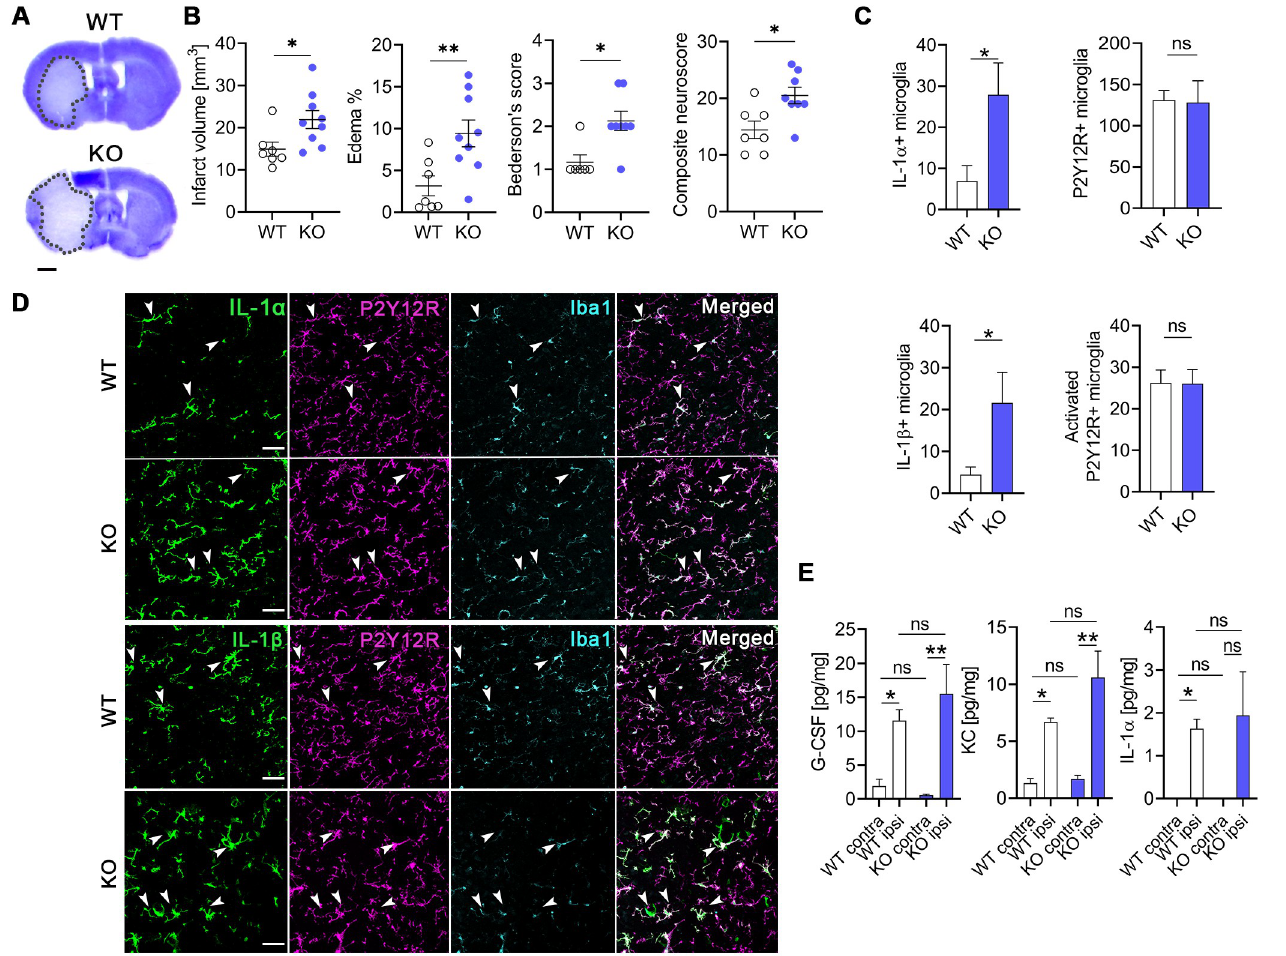
Fig 6. Deletion of microglial NKCC1 increases infarct volume, brain edema, and worsens neurological outcome after MCAo. (A, B) Microglial NKCC1-deficient mice (KO) show larger infarct volume as assessed on cresyl violet-stained brain sections and more severe neurological outcome compared to WT mice. ( C, D) Microglial NKCC1 deletion results in higher levels of IL-1 α and IL-1 β 24 hours after MCAo. (E) Cytokine levels in the cortex do not differ 8 hours after MCAo in KO mice compared to WT. (A) Scale: 1 mm. (B) Unpaired t test, N (WT) = 7, N (KO) = 9; � : p < 0.05, �� : p < 0.01. (C) Mann–Whitney test, � : p < 0.05; N (WT) = 7, N (KO) = 8. ( D) Scale: 50 μ m. ( E) Kruskall–Wallis test followed by Dunn’s multiple comparison test; N = 6/group. � : p < 0.05, �� : p < 0.01. Data underlying this figure can be found in S1 Data. KO, knockout; MCAo, middle cerebral artery occlusion; ns, not significant; WT, wild type.